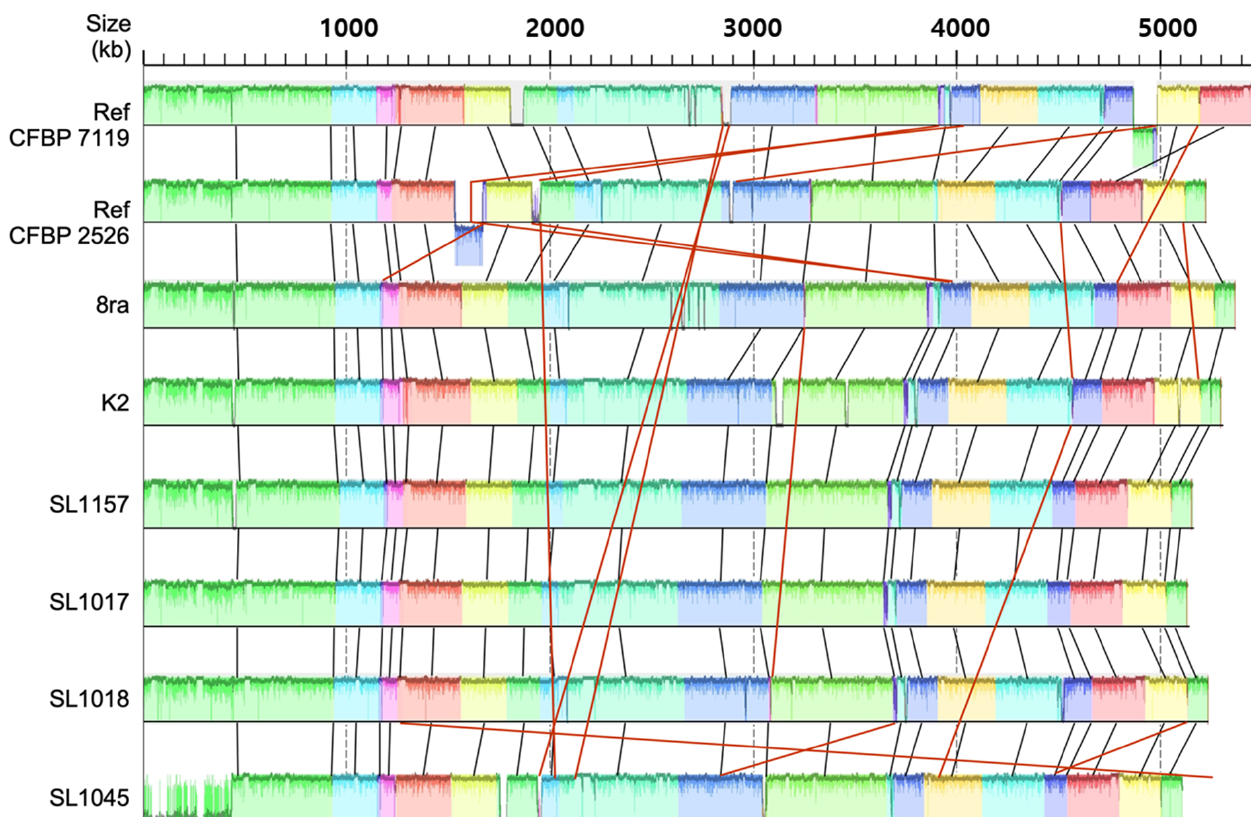
Figure 1. Whole-genome comparison of eight X. citri pv. glycines strains by Progressive Mauve alignment. CFBP 7119 and CFBP 2526, isolated in Sudan and Brazil, respectively, were used as reference genomes for comparison [19]. The scale represents coordinates of each genome. Different color blocks represent LCBs (Local Collinear Blocks), which are conserved segments within the genomes. Within a LCB, the white area represents low similarity regions or regions unique to one genome but absent in another. Colored lines indicate rearrangement of LCBs between the genomes.